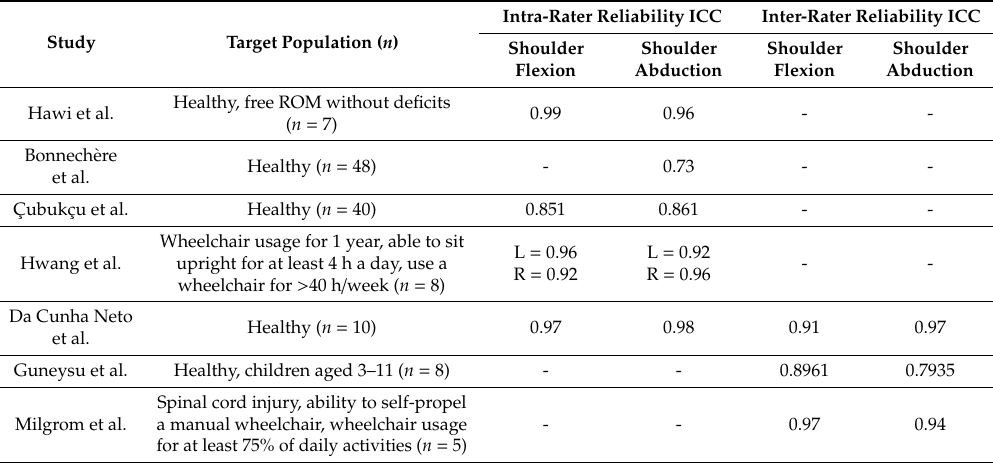
Table 1. Summary of Kinect reliability